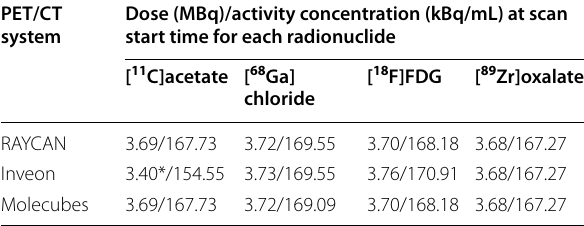
Table 4 Doses and activity concentrations at scan start times with acquisition times of the radiotracers on different PET/CT